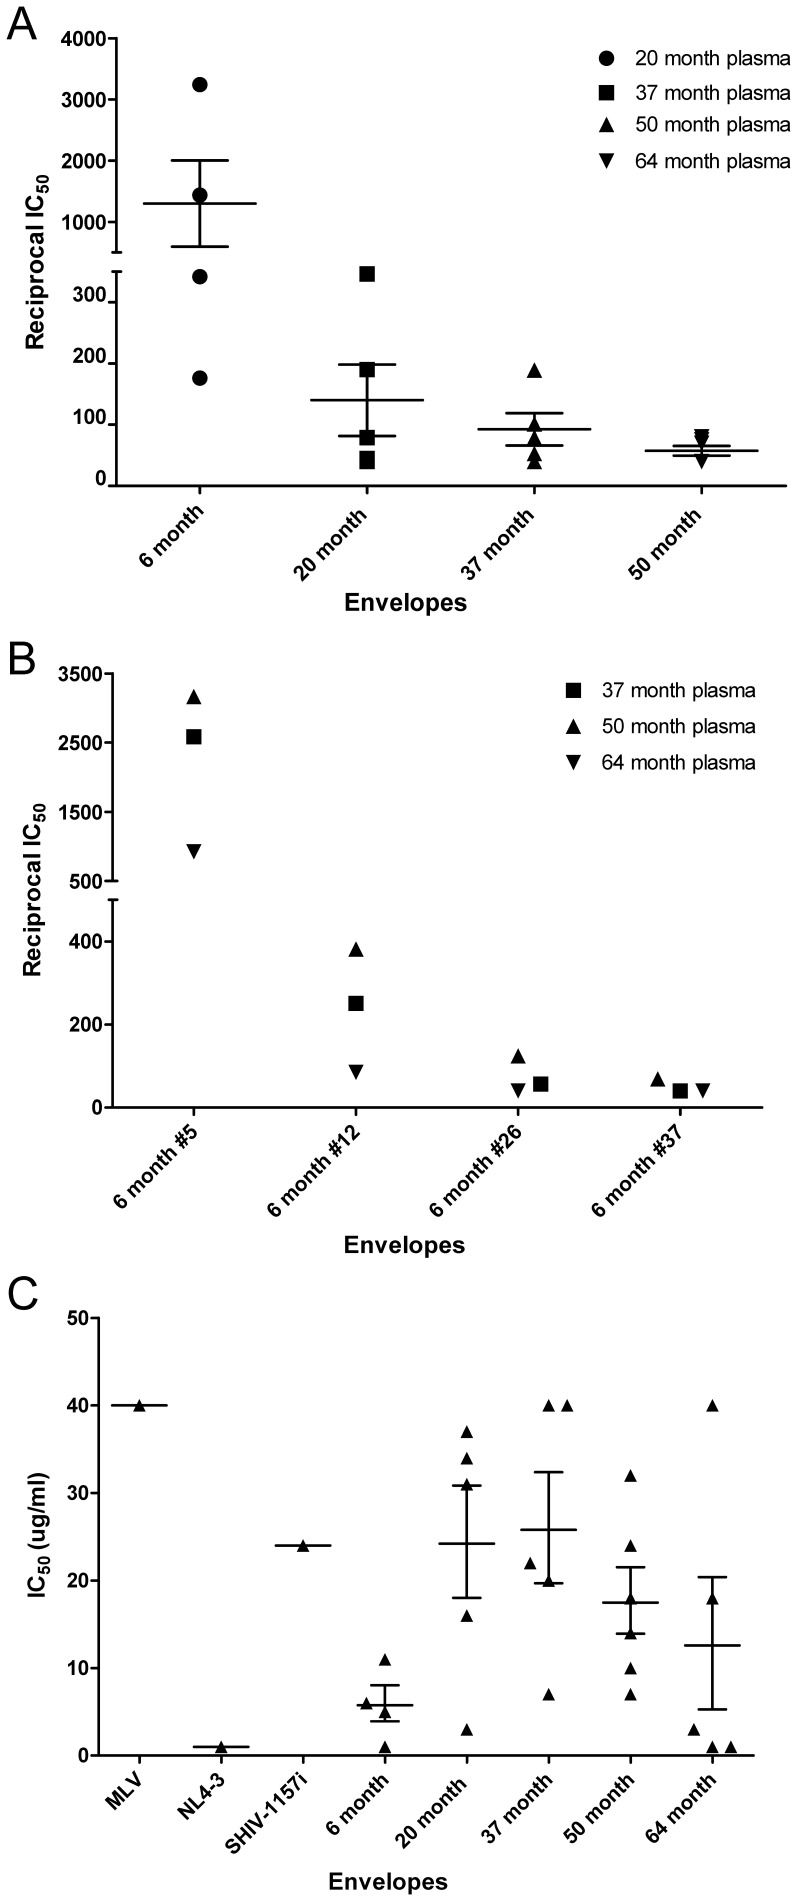
Envelope neutralization characteristics.(A) Pseudotyped viruses with envelopes from 6 months pi were tested against non-contemporaneous plasma from 20 months pi, 20 months pi were tested against non-contemporaneous plasma from 37 months pi, 37 months pi envelope clones against 50 months pi plasma and 50 months pi envelope clones against 64 months pi plasma. Each symbol represents a pseudotyped virus encoding an individual envelope clone from that particular time point. (B) Pseudotyped viruses with envelopes from 6 month pi were tested against plasma of 37, 50 and 64 months pi. (C) Pseudotyped viruses with envelopes from various time points were tested against pooled mAbs. Envelopes from the infectious molecular clone inoculum (SHIV-1157i), murine leukemia virus (MLV) and NL4-3 served as controls. Each symbol represents a pseudotyped virus encoding an individual envelope clone from that particular time point.